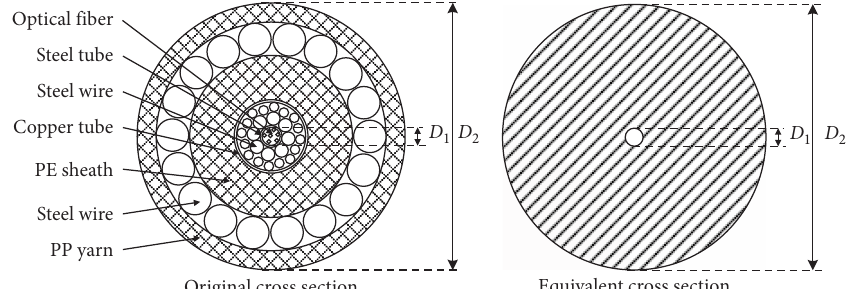
Figure 1: Equivalent cross section of the single armored